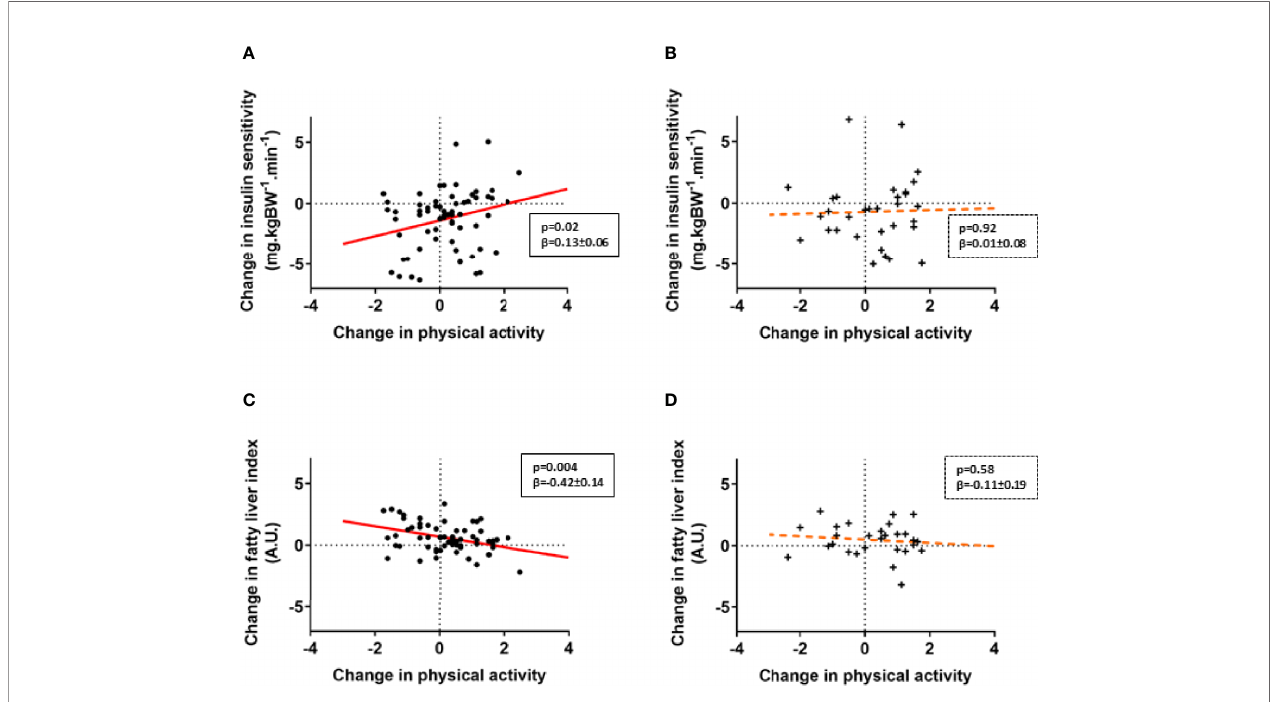
FIGURE 2 | NDUFB6 SNP allele modulates responder status to changes in physical activity. Associations of changes in PA levels and insulin sensitivity (A, B) as well as liver fat estimates (C,D) are displayed for patients with type 2 diabetes, strati fi ed according to genotype. Type 2 diabetes carriers of the G/G allele of the rs540467 single nucleotide polymorphism of the NDUFB6 gene are marked as dots ( (cid:129) ), carriers of the G/A and A/A genotype are marked as crosses (+). The solid regression line depicts a strong trend or a signi fi cant association whereas the dotted line represents non-signi fi cant associations. Change in insulin sensitivity on the y-axis refer to ln M-value difference while change in physical activity on the x-axis refers to the Baecke index